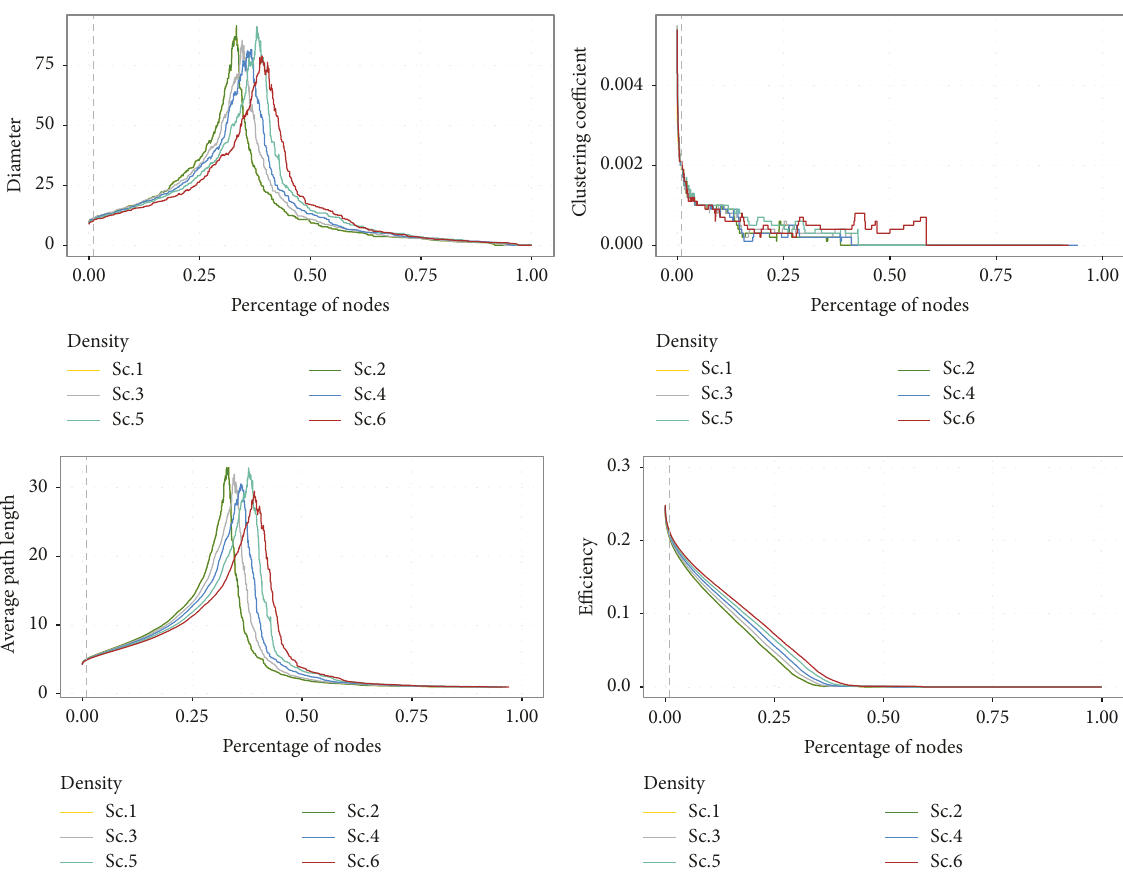
Figure 7: Resilience for simultaneous attack simulations with progressive manipulation of the number of links in the network periphery. The dashed line is placed in correspondence with the rich-club size. All results are averaged over 10